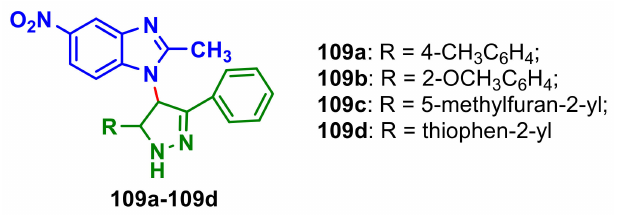
Figure 3. Benzimidazole–pyrazoles 109a – 109d . Table 14. In vitro antitumor activity of the compounds 109a – 109d toward A-549, HCT-116, Hep-G2 and MCF-7 cancer cell